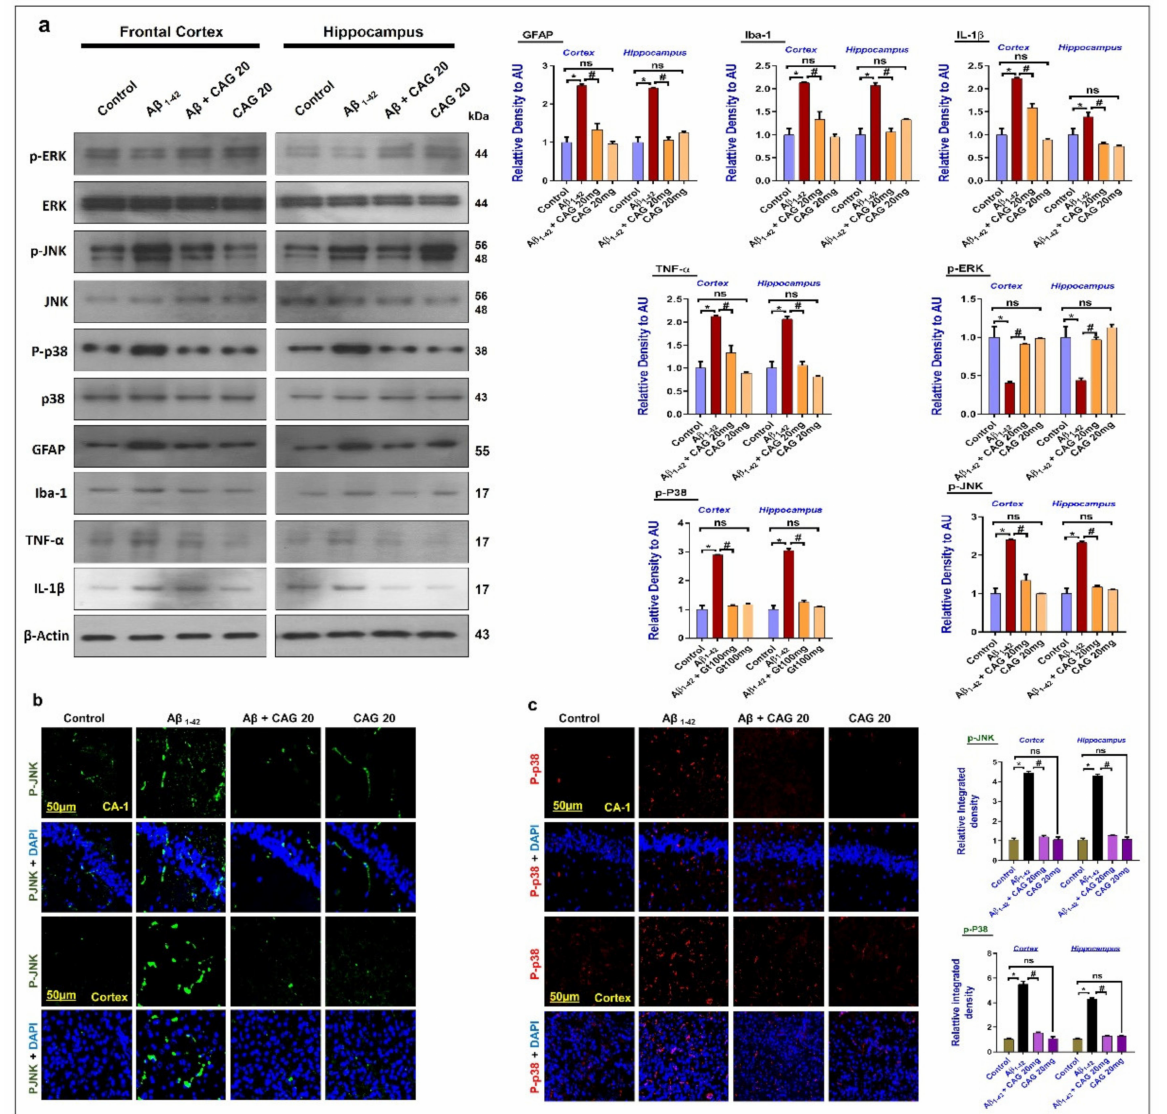
Figure 3. Effects of cycloastragenol against the A β -induced activated MAP kinases, and the inflammatory cytokines. ( a ) Western blot results of p-ERK, p-JNK, p-p38, GFAP, Iba-1, TNF- α , and IL-1 β in the frontal cortex and hippocampus of experimental mice’s brains, with respective bar graphs. ( b , c ) Immunofluorescence analysis of p-JNK and p-p38 in the frontal cortex and hippocampus of experimental mice, scale bar is 50 µ m. In panel-1 b , c , green is A β , red is p-P38 and blue is DAPI. The p -value < 0.05 was considered a significant difference. * showing a significantly different from the control group; # significantly different from the A β -injected group. Significant difference = * p < 0.05; # p < 0.05. CAG20: Cycloastragenol 20 mg/kg, DAPI: 4 (cid:48) ,6-diamidino-2-phenylindole, A β : Amyloid beta, CAG: Cycloastragenol, ns: non-significant